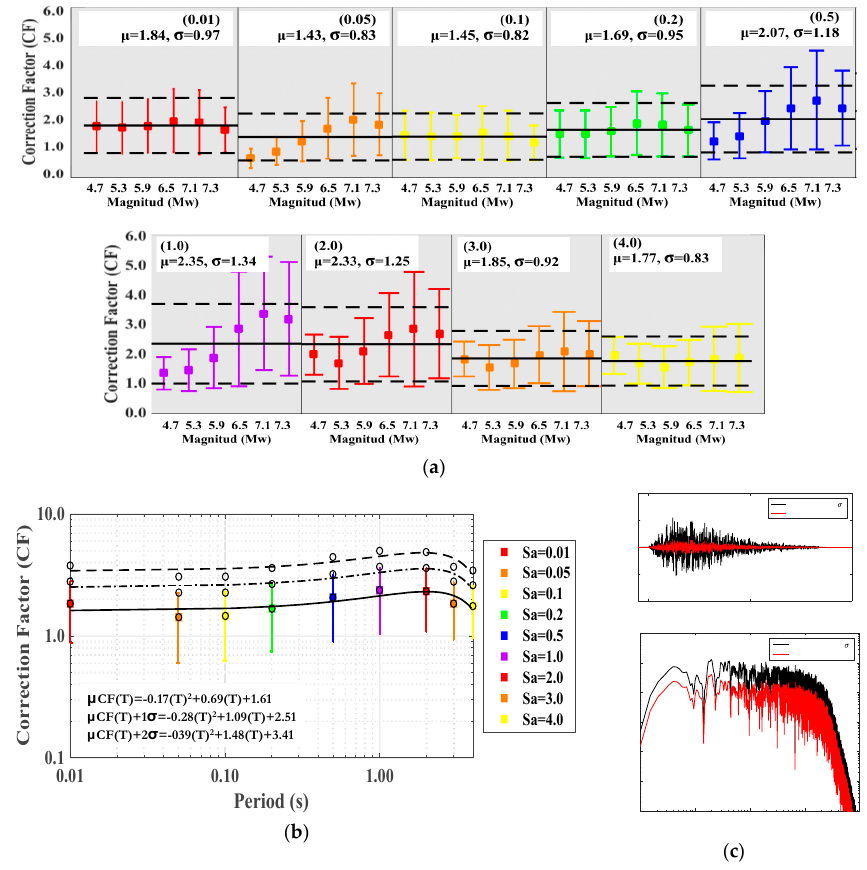
Figure 8. ( a ) Correction factors or ratios between synthetic accelerations and accelerations predicted by AA14 (adjusted at V S30 = 2600 m/s), for a series of magnitudes at different spectral periods: median ± one standard deviation of all available ratios for a given magnitude (M w ), μ is the median of all median correction factors when considering all magnitudes, and σ the corresponding standard deviation. ( b ) Variation of the correction factor with spectral period estimated over all magnitudes and distances: black solid line: interpolated frequency-dependent median correction factor; dashed line: median + one standard deviation; dot-dashed: median + two standard deviations. ( c ) Example of an M w = 7.9 accelerogram generated using SMSIM (red) and then scaled by the interpolated median + two standard deviations correction factor